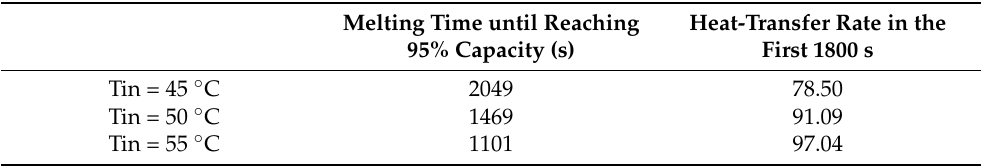
Table 4. Melting time until achieving 95% and the heat-transfer rate in 1800 s for the cases of inlet HTF temperature of Tin = 45 ◦ C, Tin = 50 ◦ C, and Tin = 55 ◦